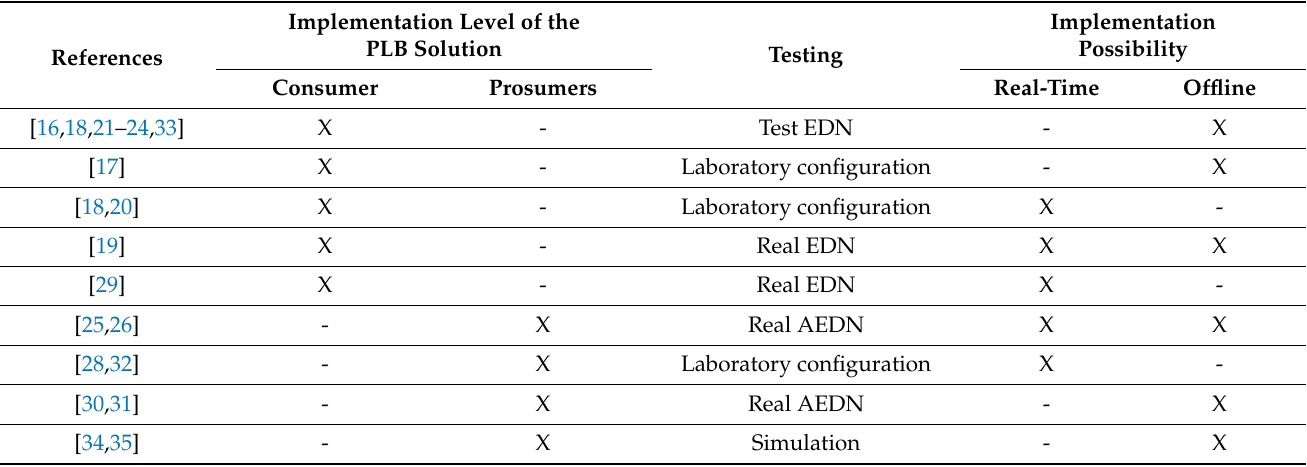
Table 1. A comparative state-of-the-art of the proposed PLB